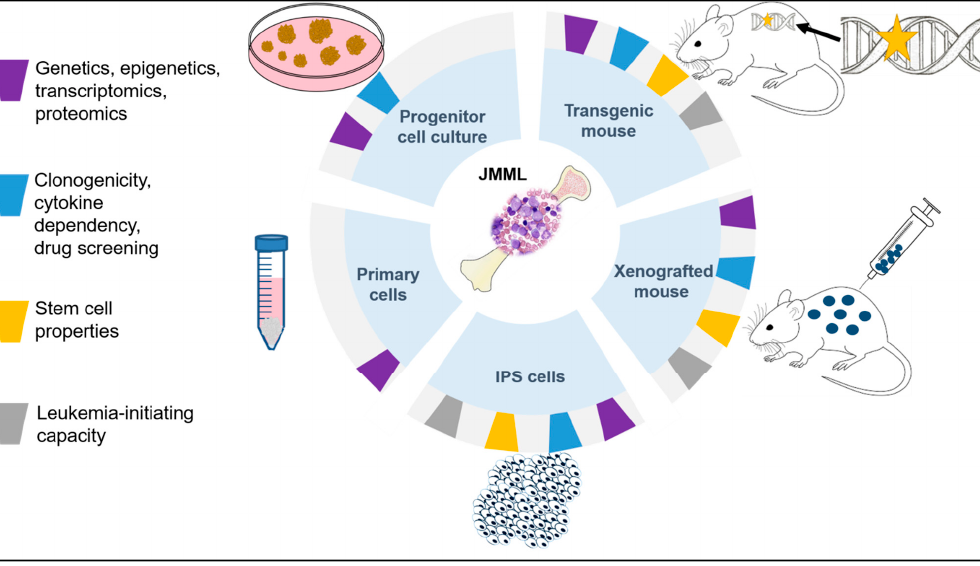
Figure 1. Preclinical modeling of JMML.